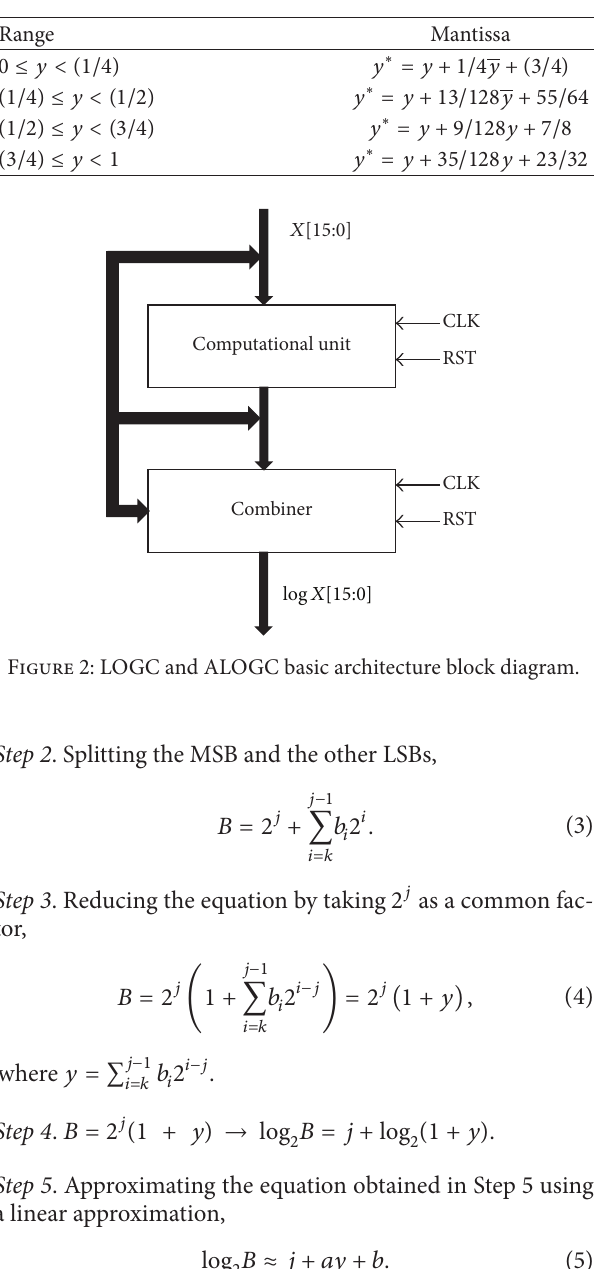
Table 4: Coefficients of 𝑎 and 𝑏 for antilogarithmic conversion.